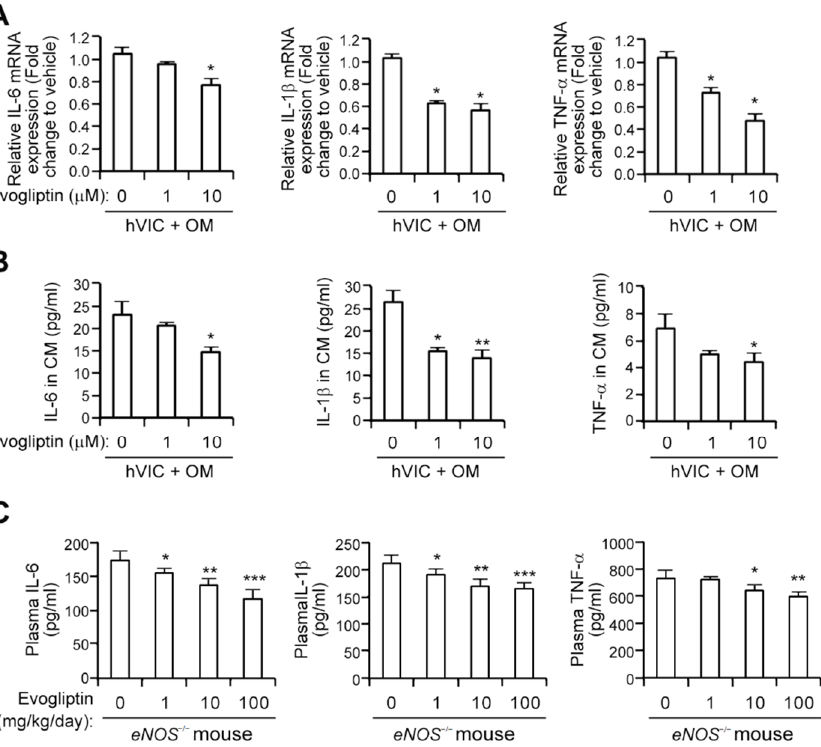
Figure 3. Evogliptin attenuates the expression of proinflammatory cytokines. ( A ) qPCR analysis was conducted to evaluate mRNA expression levels of IL-6, IL-1 β , and TNF- α in hVICs in the presence of the indicated concentrations of evogliptin. ( B ) The protein levels of IL-6, IL-1 β , and TNF- α in the conditioned media from hVICs treated with indicated concentrations of evogliptin were determined utilizing ELISA. ( C ) IL-6, IL-1 β , and TNF- α plasma concentrations in the mice were determined using ELISA ( n = 6, each group) at 12 weeks after the administration of evogliptin. * p < 0.05, ** p < 0.005, *** p < 0.0005 versus vehicle control. Data represent the mean ± SD. p values were obtained using a Kruskal-Wallis